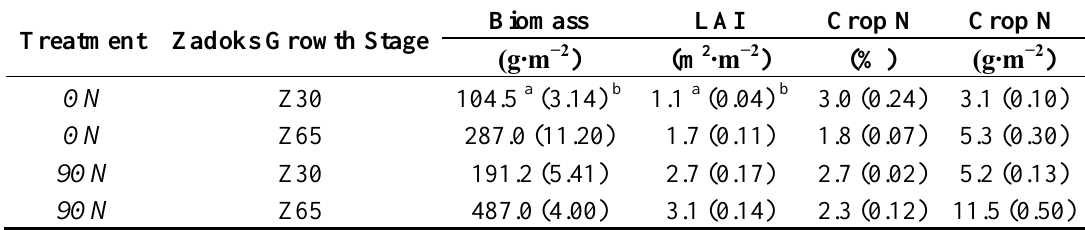
Table 2. Mean wheat biophysical variables from Foggia (Italy) for the 2006/2007 growing season at stages Z30 and Z65 for cultivar “Ofanto”.